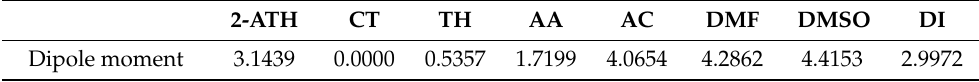
Table 1. The dipole moment calculated value. 2-ATH